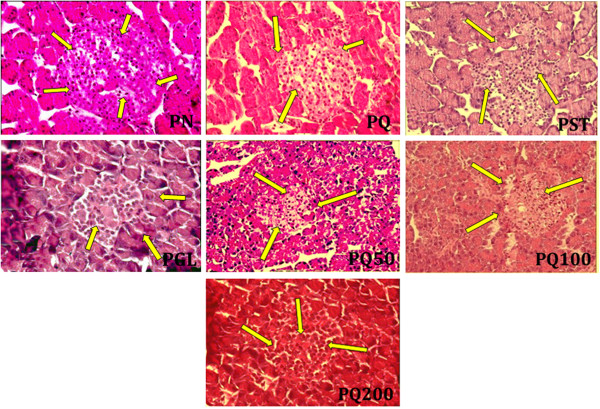
PN = Photomicrograph of section of normal pancreas (150x), showing normal lobules of pancreatic acini. PQ = Photomicrograph of section of pancreas (150x) of normal rat administered with 200 mg/kg/p.o of Qurs Tabasheer, showing normal lobules and pancreatic acini. PST = Photomicrograph of section of pancreas of STZ treated diabetic Wistar rat, 150x, yellow arrows showing lobules of pancreatic acini with areas of fibrosis. PGL = Photomicrograph of section of pancreas of diabetic rat treated with Glimepiride alone for 28 days, (150x), yellow arrows showing mild fibrosis of pancreatic acini. PQ 50 = Section of pancreas of diabetic Wistar rat treated with Qurs Tabasheer (50 mg/kg p.o) for 28 days, (150x), yellow arrows showing mild fibrosis of pancreatic acini and normal islet of langerhans. PQ 100 = Photomicrograph of section of pancreas of diabetic Wistar rat treated with Qurs Tabasheer (100 mg/kg p.o) for 28 days (150x), yellow arrows showing very mild fibrosis of pancreatic acini. PQ 200 = Photomicrograph of section of pancreas of diabetic Wistar rat treated with with Qurs Tabasheer (200 mg/kg p.o) for 28 days (150x), yellow arrows showing normal pancreatic acini and islet of langerhans.